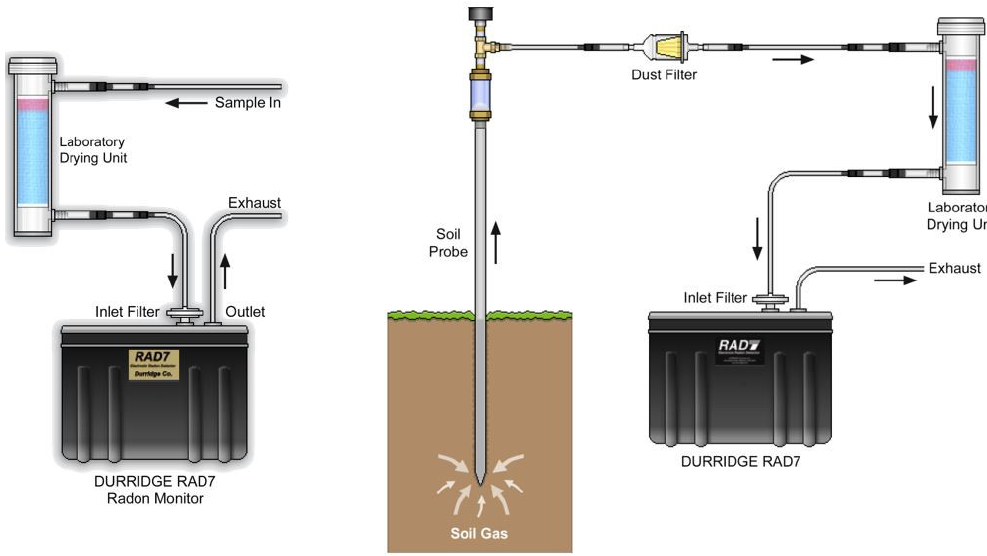
Figure 3. RAD7 Normal Configuration for indoor Radon and Soil Gas Probe configuration.